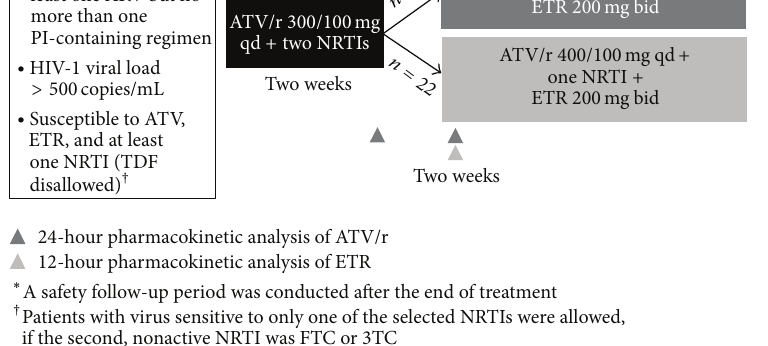
exposure to etravirine was comparable between the